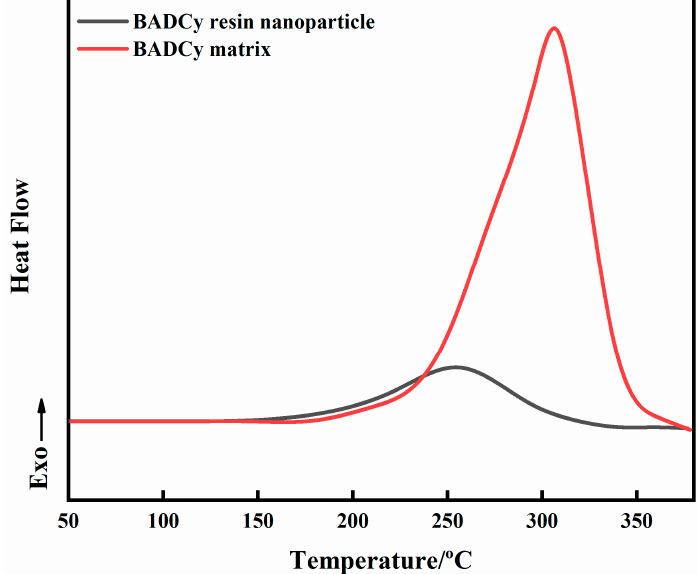
Figure 4. Di ff erential scanning calorimetry (DSC) curves of the BADCy prepolymer matrix and BADCy resin Figure 4. Differential scanning calorimetry ( DSC) curves of the BADCy prepolymer matrix and BADCy resin nanoparticles.